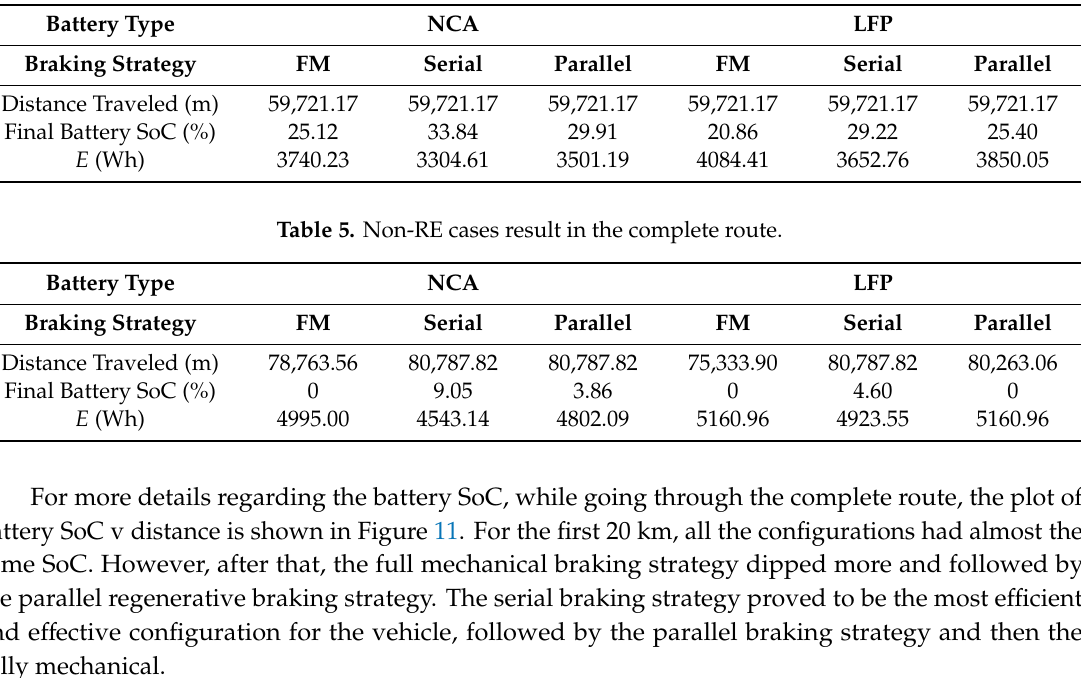
Table 4. Non-RE cases result in the first route.